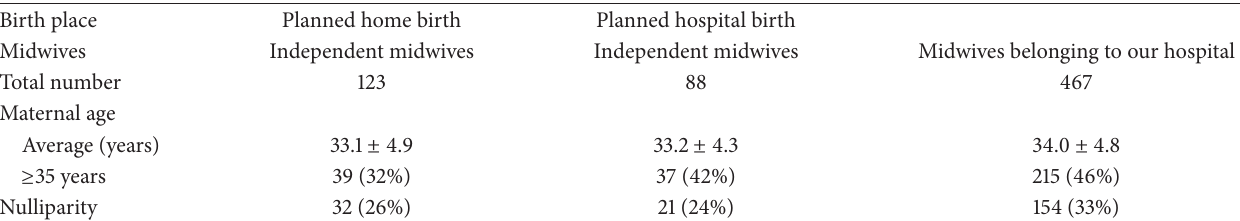
Table 1: Clinical descriptions of pregnant women initially considered as “low-risk” for receiving our 3 midwife-led primary delivery care